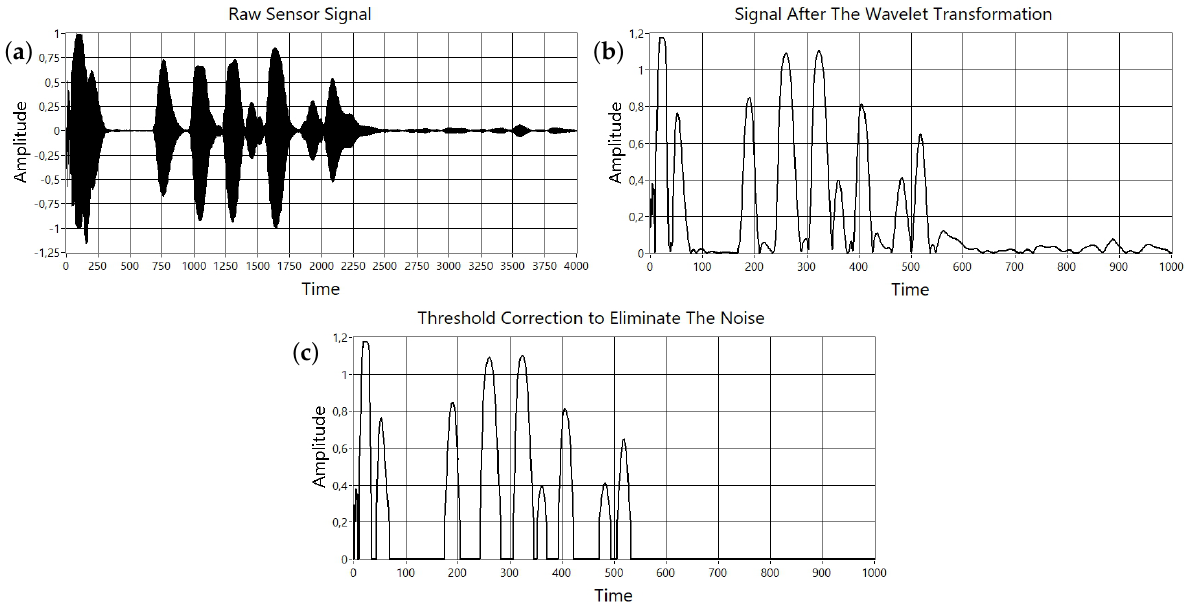
Figure 14. Two consecutive wavelet transformations—Daubechies 4—on a raw sensor signal, and a threshold correction as the preparation of the peak detection. Subplot ( a ): the raw sensor signal. Subplot ( b ): the signals after two wavelet transforms. Subplot ( c ): the transformed signals after the threshold